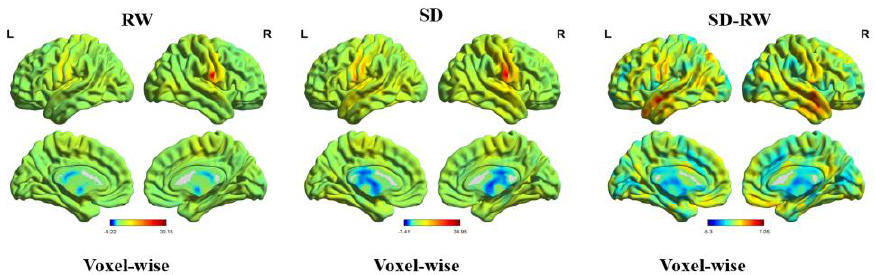
Figure 5. Voxel-wise functional connectivity map. Compared to RW, right postcentral and left middle temporal and right inferior temporal functional connectivity significantly increased following SD. RW, rested wakefulness; SD, sleep deprivation; R, right; L, left.